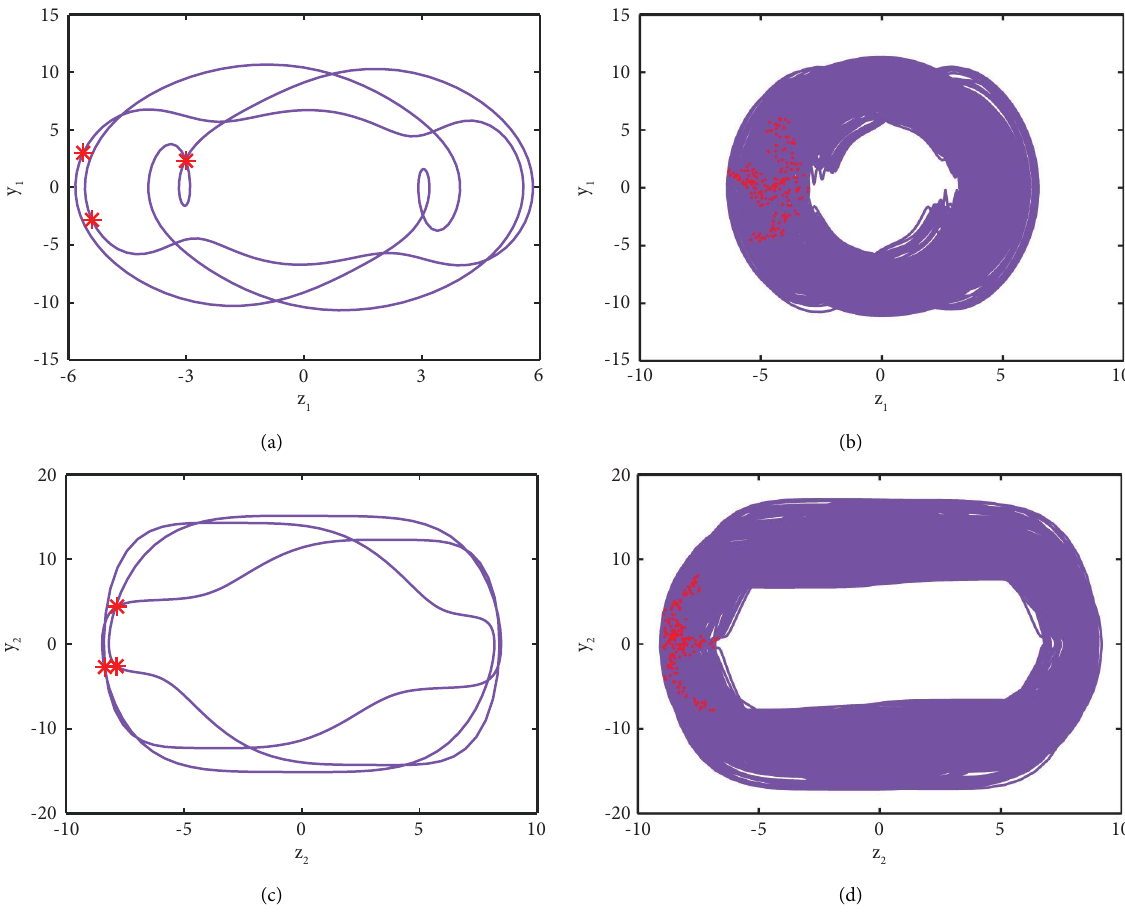
Figure 5: Te phase trajectories of the diferent attractors. (a) Te mechanical equipment peroid-3 attractor. (b) Te mechanical equipment chaotic attractor. (c) Te NES period-3 attractor. (d) Te NES chaotic attractor.